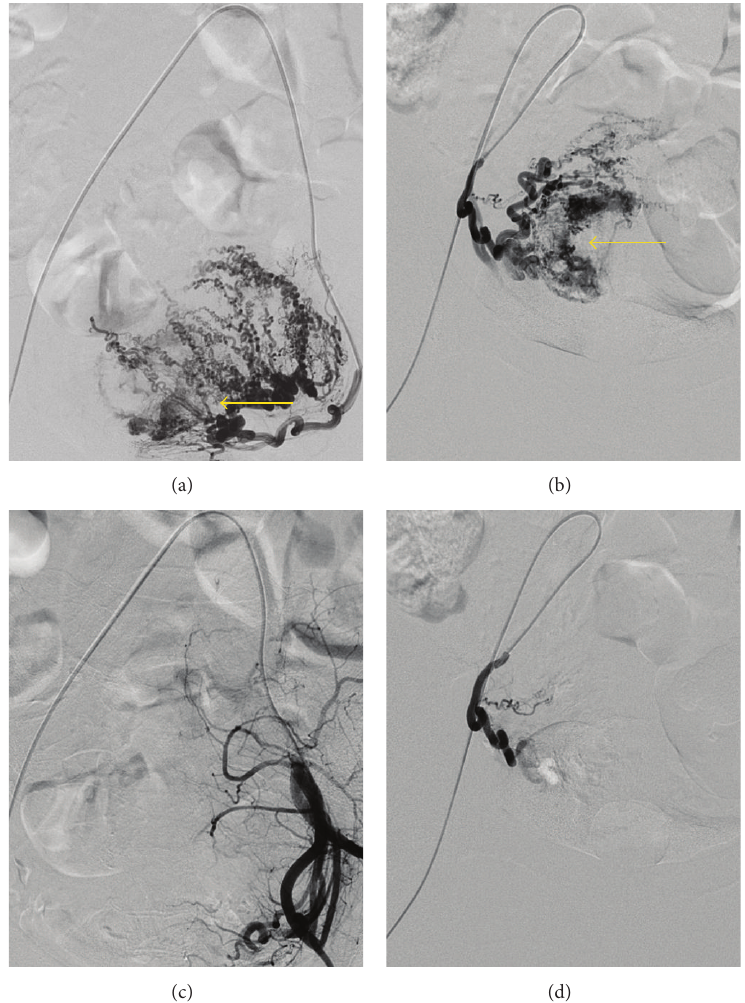
Figure 1: (a, b) Selective bilateral uterine arteries DSA showing persistence of the prominent vessel in the lower anterior uterine wall and gestational sac measuring about 4 cm × 4cm (arrow). (c, d) Postembolisation angiogram showing complete occlusion of the bilateral uterine artery and gestational sac